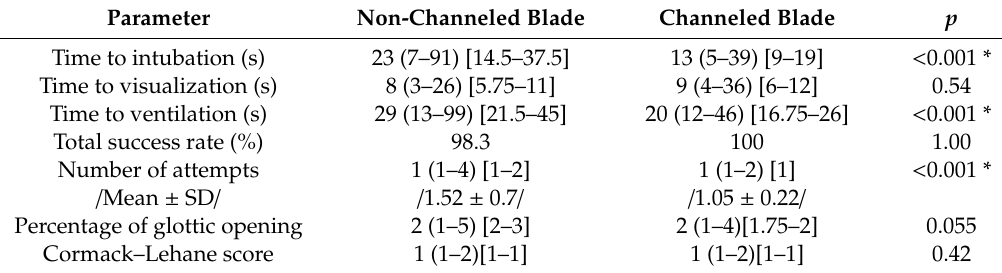
Table 2. Primary and secondary outcomes of the study.